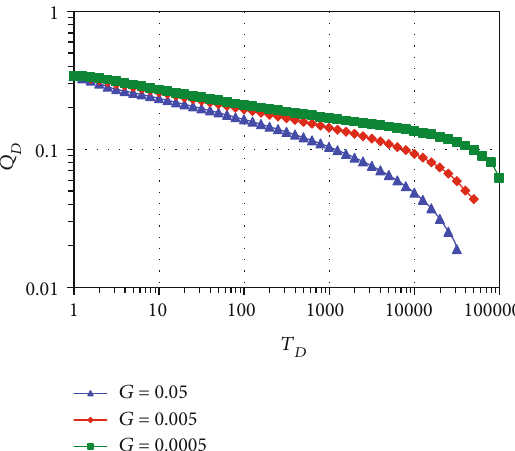
Figure 11: Dimensionless productivity curve under di ff erent threshold pressure